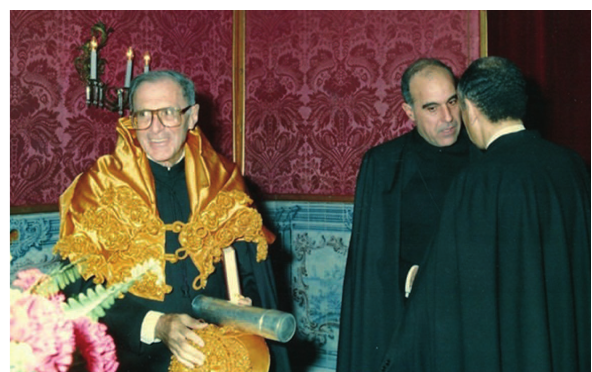
Fig. 12 – Zerbini recebendo o título de Doutor Honoris Causa, pela Universidade de Coimbra